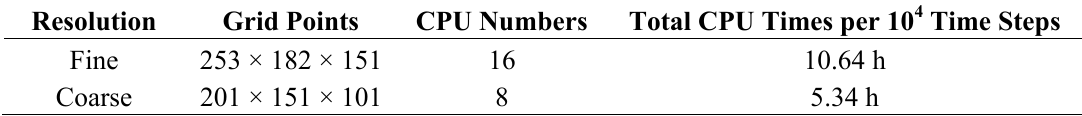
Table 14. Comparison of computation